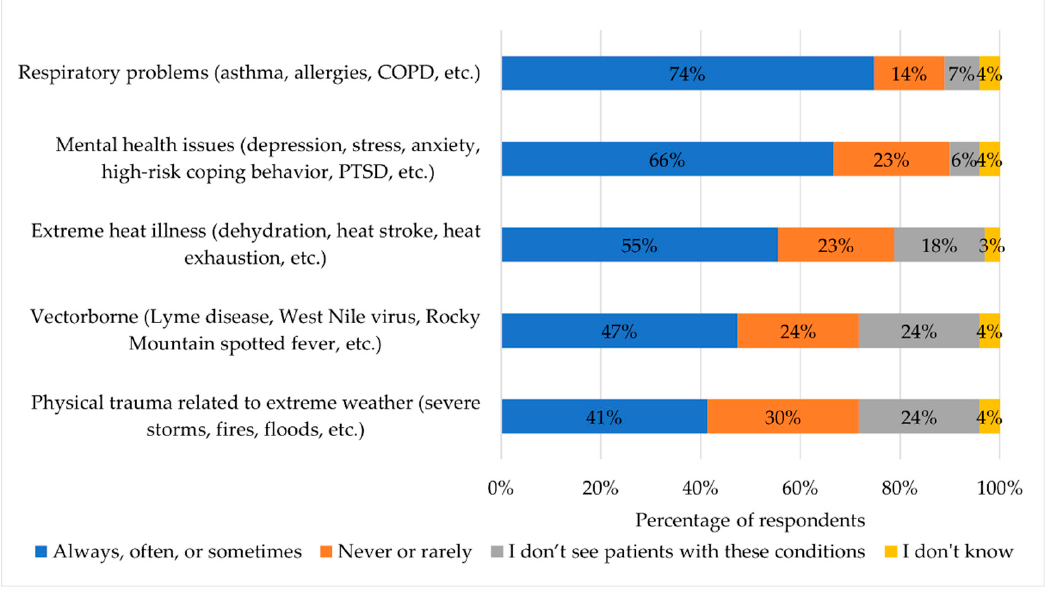
Figure 1. Perceived impact of climate change on patient or client health conditions (n = 3443).